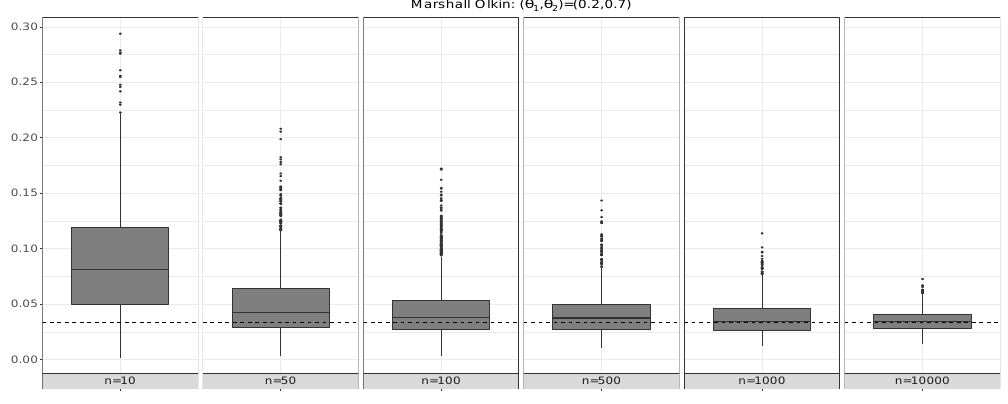
Figure 2: Boxplot summarizing the 1000 obtained estimates for CoES =